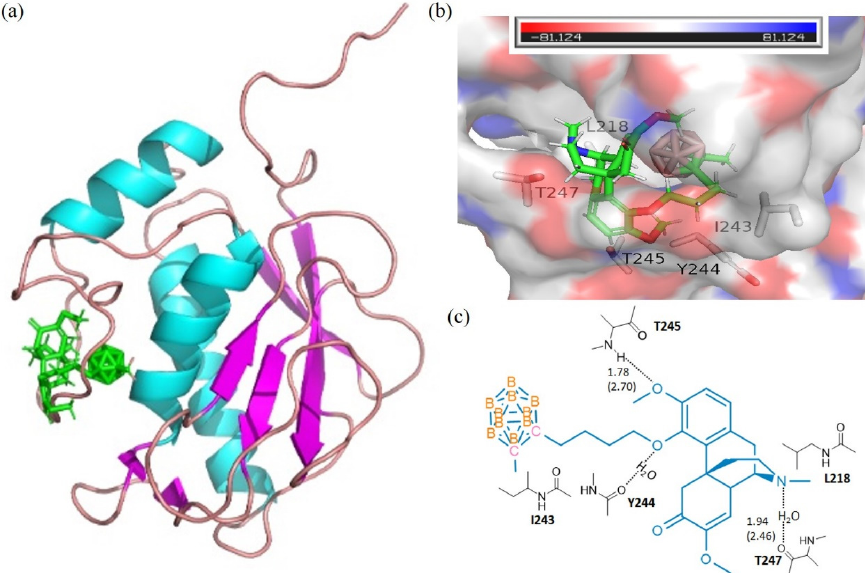
Figure 2. The docking models for 3 with collagenases MMP13-2YIG. ( a ) domain structures of the interaction of 3 (green) and MMP13-2YIG (ribbon diagram illustrating). The figure was generated using the pymol 2.4 software. ( b ) MMP13-2YIG active site pocket with bound moiety of 3 . The collagenase surface is colored by electrostatic potential; blue for positive and red for negative. The figure was generated using the pymol 2.4 software; ( c ) interactions (hydrogen bonds) of amino acid residues with 3 . The figure was generated using Chemdraw 10.0 and pymol 2.4 software.